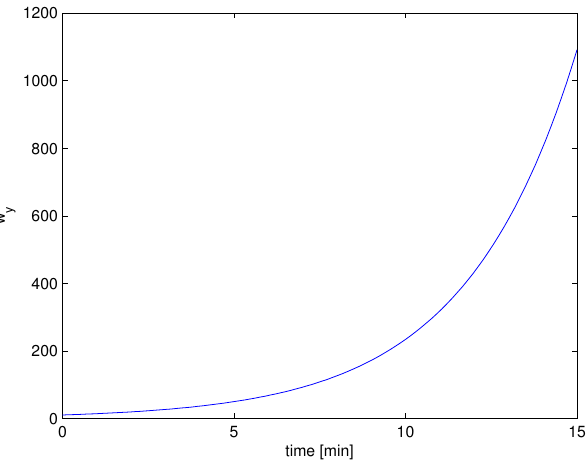
Figure 8. Reference signal minimizing J 2